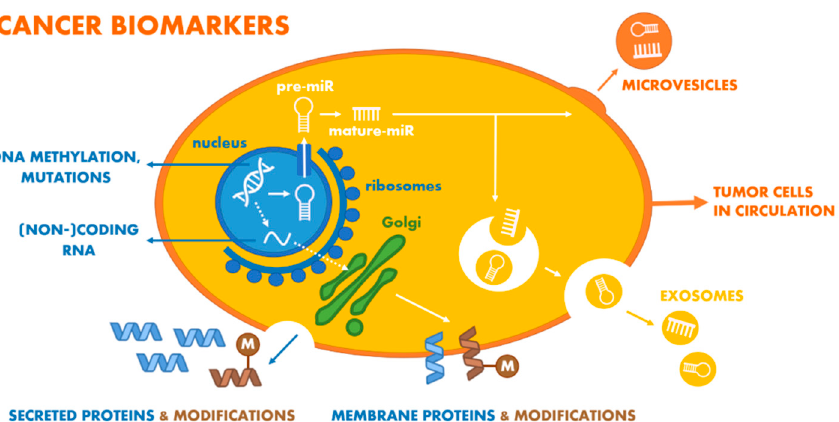
Figure 4. Schematic presentation of a cancer cell synthesising different types of cancer markers: (i) intracellular markers—DNA methylations and mutations (present in nucleus); (ii) surface (mem- brane) markers present on cell surface; and (iii) extracellular markers—secreted (soluble) proteins, extracellular vesicles, exosomes and circulating tumour cells also.